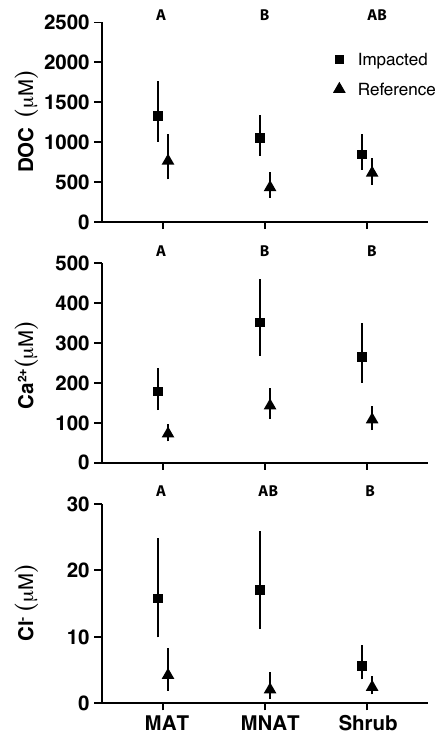
Figure 10. Mean ( ± 95% CI) of DOC for thermokarst outflow and reference water from sites occurring on moist acidic (MAT), nonacidic (MNAT), and shrub tundra. Different letters above pan- els represent significant differences between feature types. DOC, Ca 2 + , and Cl − were the only parameters for which vegetation was a significant predictor in the mixed-effects ANOVA when account- ing for development stage, feature type, and landscape